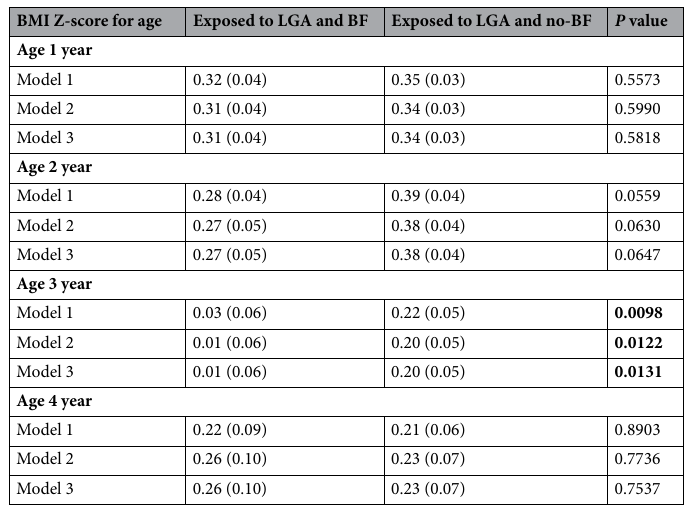
Table 2. Comparison of offspring BMI Z-scores according to offspring were breast-feeding and large- for-gestational age for different age. Data are showed as mean (SE). BMI body mass index, LGA large-for- gestational age, BF breast-feeding. Model 1: adjusted for pre-pregnancy BMI; Model 2: adjusted for covariates in Model 1 + child sex, maternal age, and education; Model 3: adjusted for covariates in Model 2 + gestational diabetes